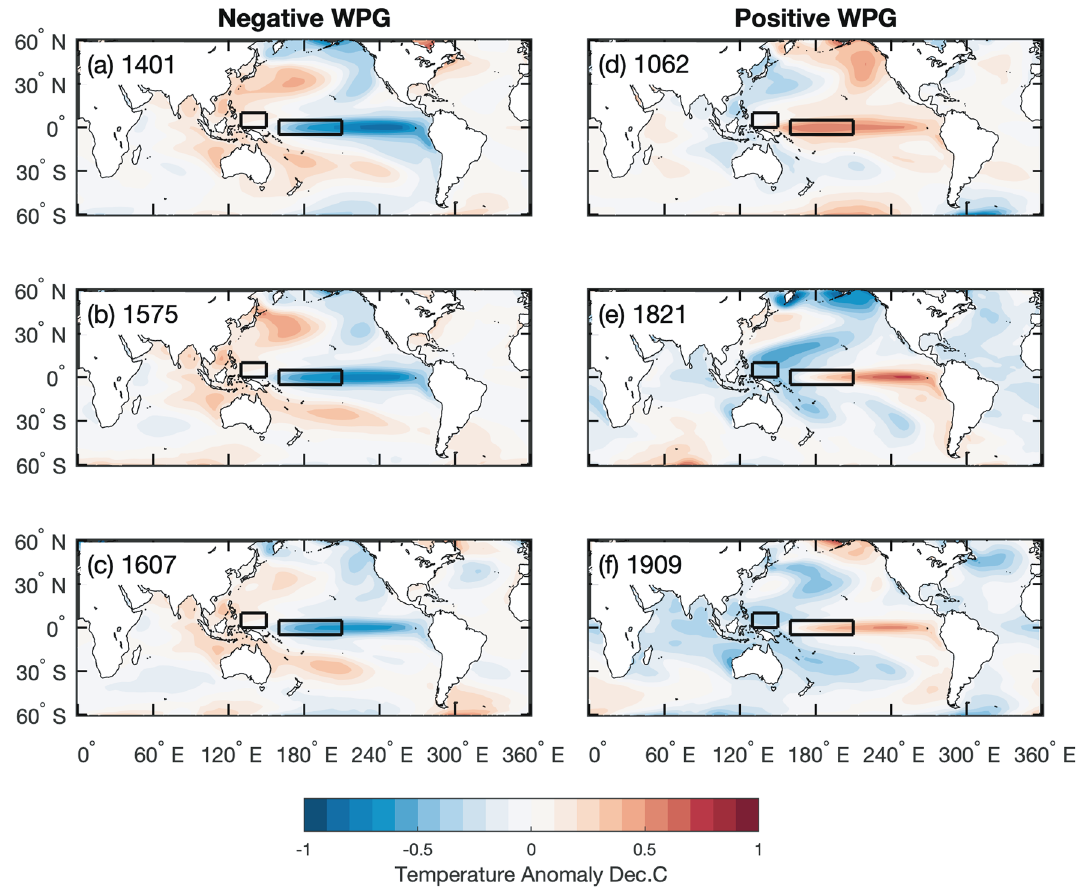
Figure 5. Composites of 20 year mean sea surface temperature anomalies (30°N–30°S, 100°E–75°W) in 34 PHYDA 46 over the past Millennium. The 20-year periods were chosen as the strongest negative ( a - c ) and positive ( d - f ) anomalies in the WGP timeseries and the anomaly is calculated relative to the 1001–2000 mean. The 20-year period is centred on the indicated year: for example, 1401 is the mean of 1392 to 1411. Location of the WPG grid boxes after Hoell and Funk 24 indicated by black rectangles. Figures created in Matlab R2020b (https:// au. mathw orks.